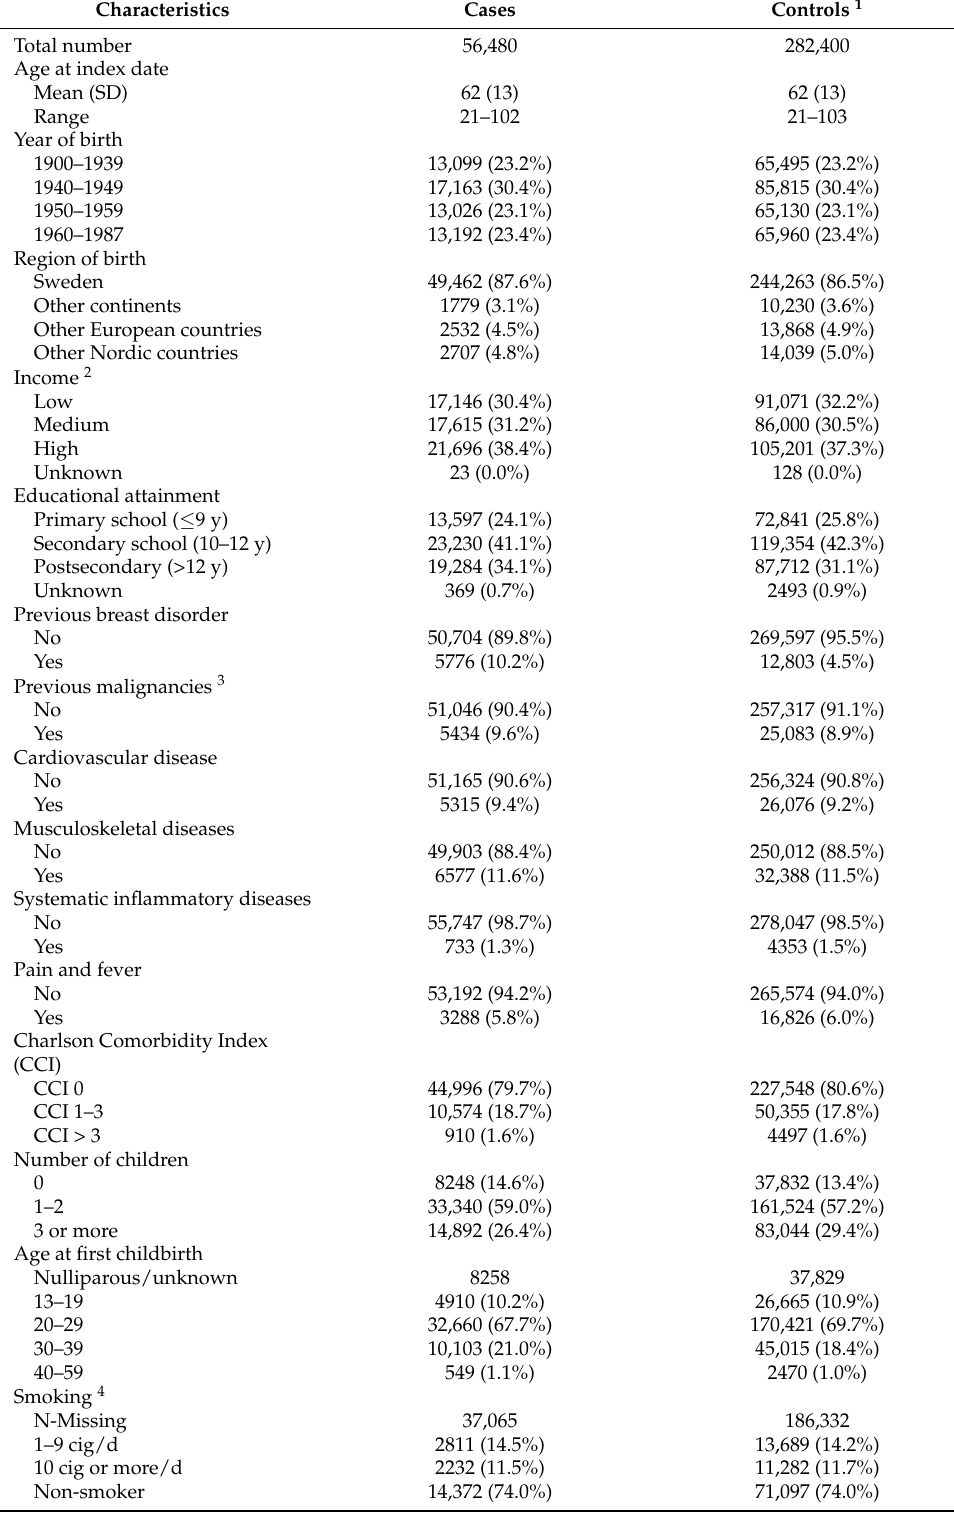
Table 1. Characteristics of women with incident breast cancer (cases) and their individually matched breast cancer-free women (controls) in an analysis of the general female population in Sweden,